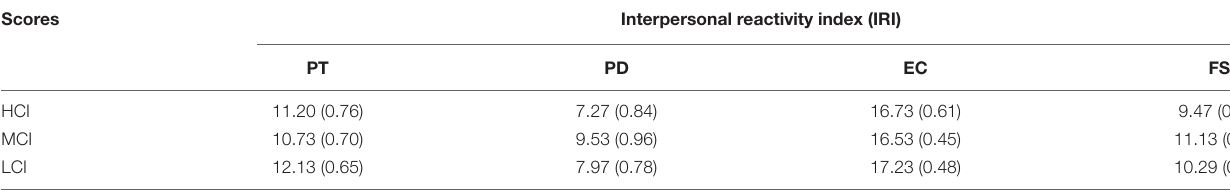
TABLE 1 | Mean scores and standard error for the subscales of the IRI. Scores